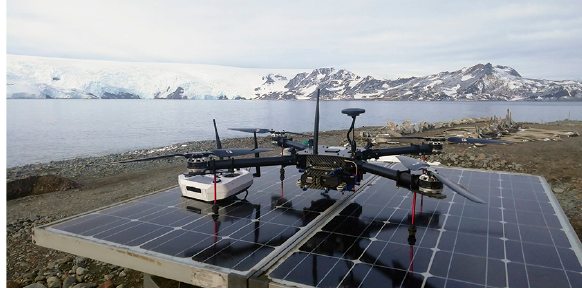
Figura 4: RPA, develop from Robotic Air Systems manufacture (Peru).